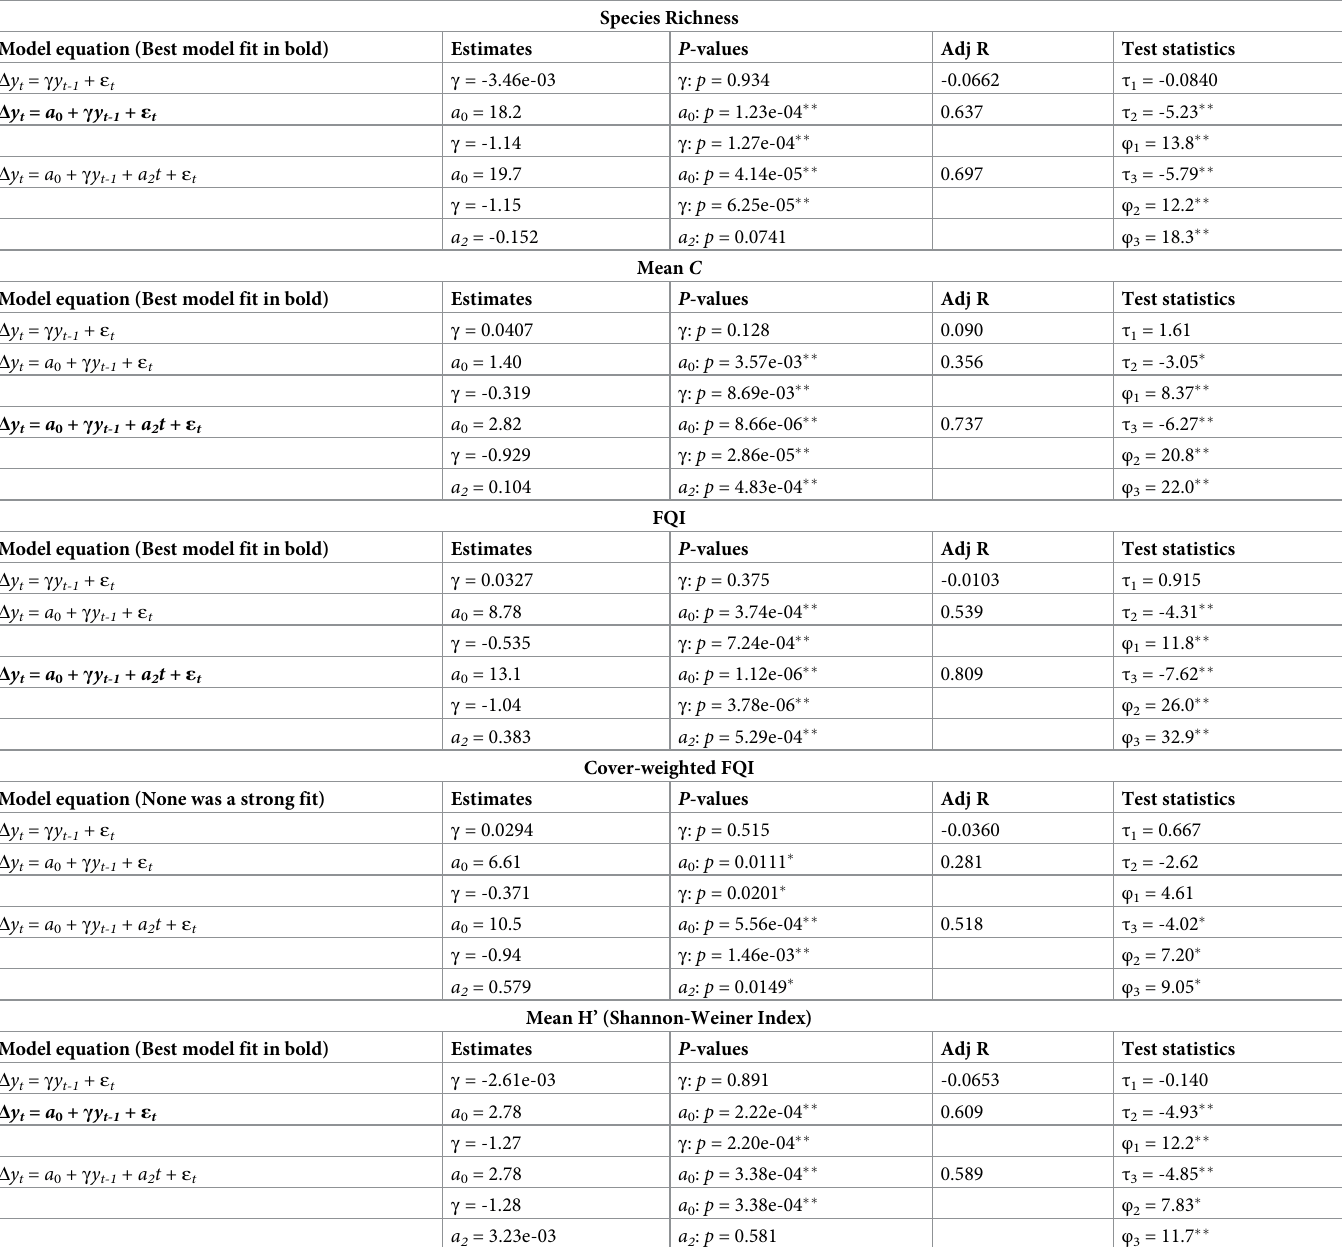
Table 1. Augmented Dickey-Fuller